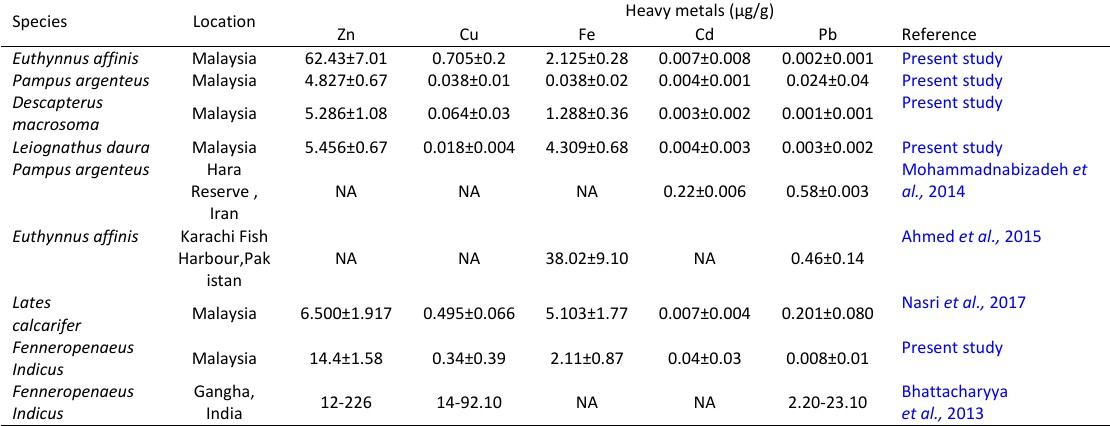
Table 2: Comparison of heavy metals in fish muscle tissue with other different studies in the world: Species